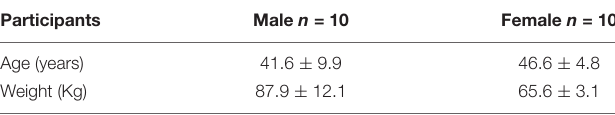
TABLE 1 | Characteristics of the